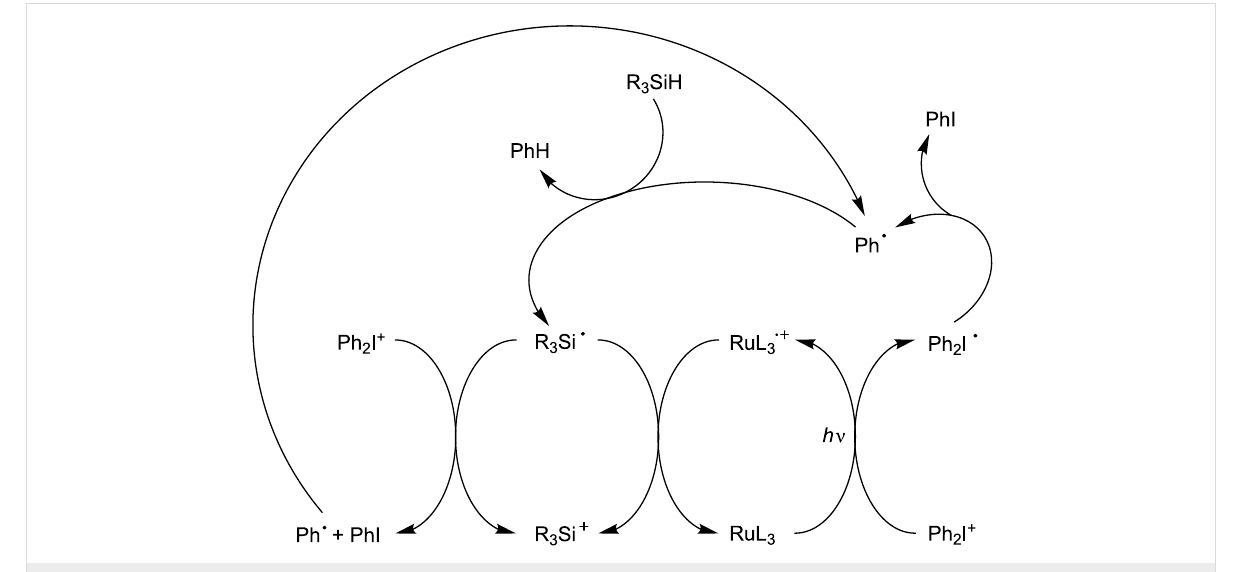
Scheme 6: Reaction mechanisms for the system Ru(bpy) 32+ /Ph 2 I + /R 3 SiH.